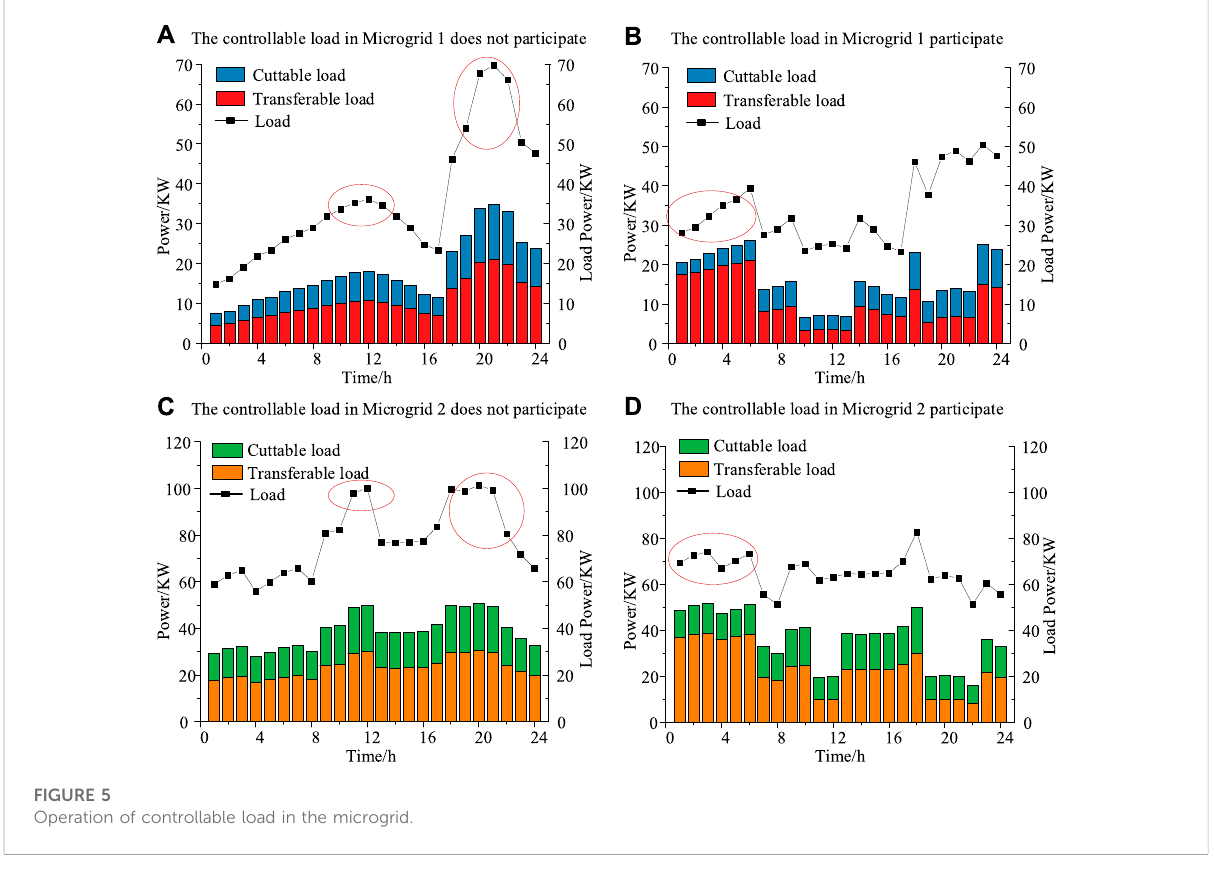
FIGURE 5 Operation of controllable load in the microgrid.